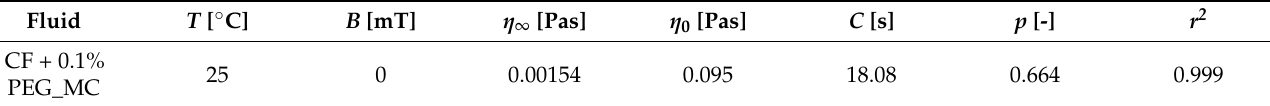
Table 1. Rheological characterization of the model suspensions.